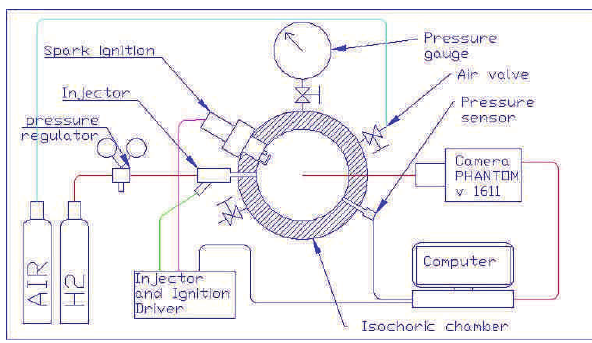
Fig. 2. Schematic diagram of the test bench